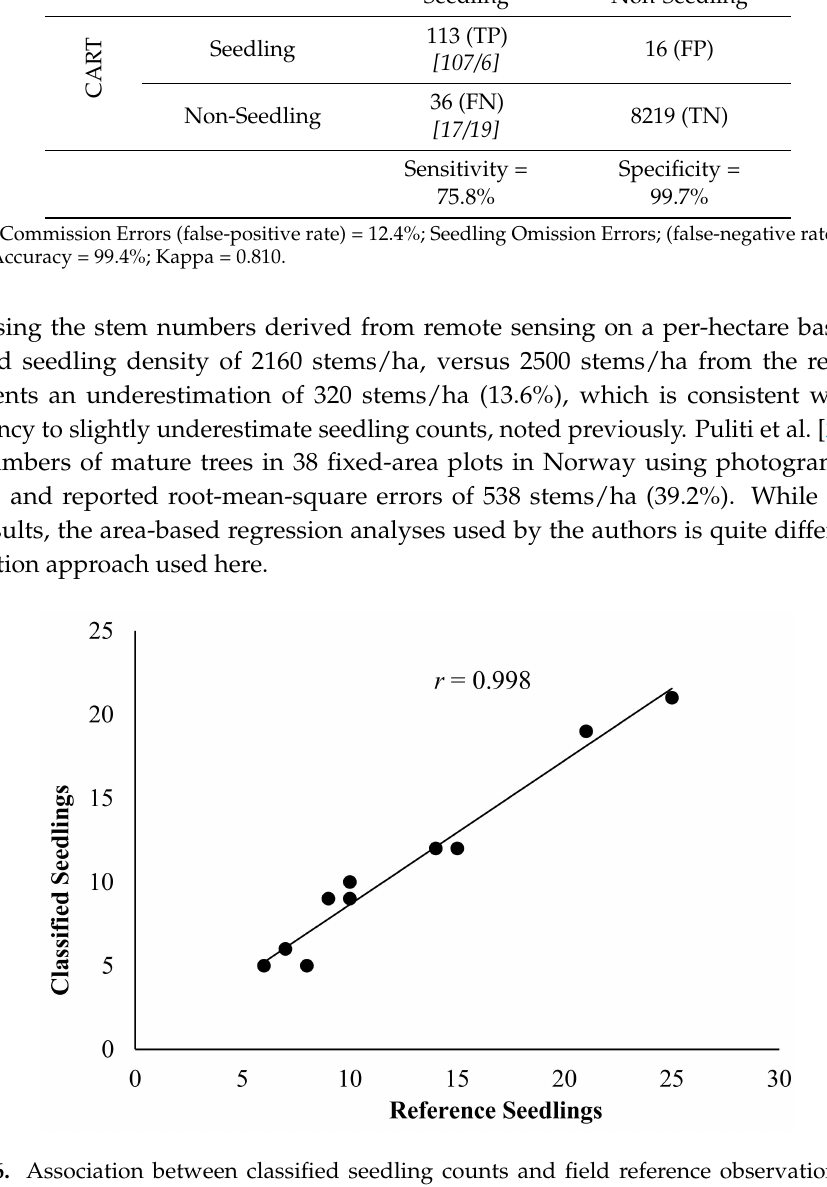
Figure 6. Association between classified seedling counts and field reference observations in the test-case